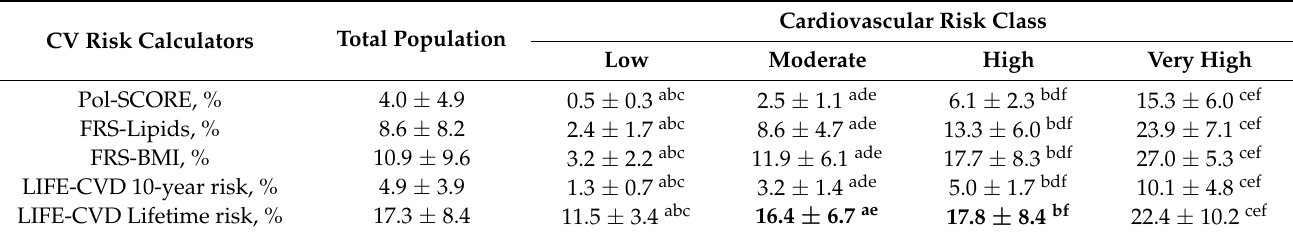
Table 4. The value of different predicting tools of the total population and of subgroup according cardiovascular risk and comparisons variables between